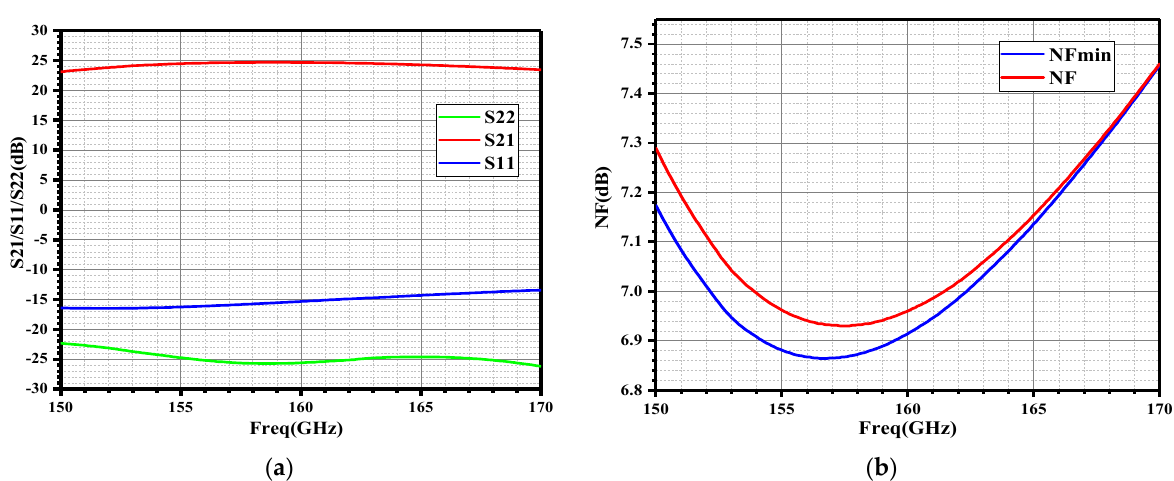
Figure 3. The simulation results of the four-stage LNA: ( a ) S-parameters; ( b ) NF.